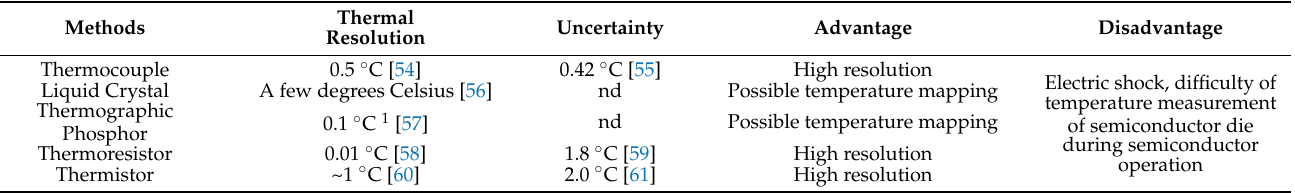
Table 1. Summarized thermal resolutions, advantages and disadvantages of all described contact methods for measuring semiconductor die